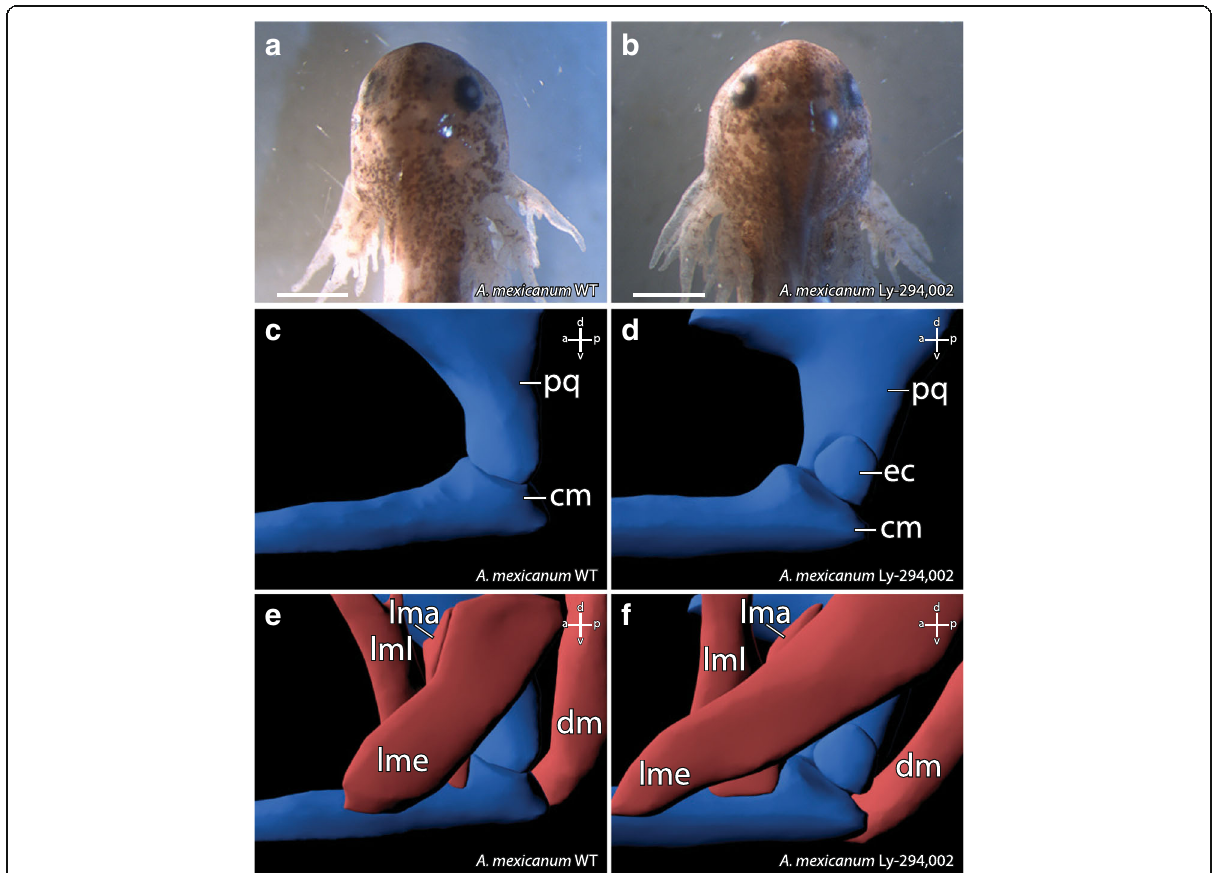
Fig. 7 Effect of Ly-294,002 treatment on the external and internal morphology of A. mexicanum . Dorsal view of a control and b Ly-294,002 treated specimens reveals no differences in external morphology. Lateral view of 3D-reconstructions based on confocal laser scanning microscopy of c control and d Ly-294,002 treated specimen shows the development of an ectopic cartilage lateral to the jaw articulation in treated specimens. The musculature of e control and f treated specimens are similar and no changes in origination or insertion of muscles can be observed after bapx1 upregulation. cm, Meckel ’ s cartilage; dm, M. depressor mandibulae; ec, ectopic cartilage; lma, M. levator mandibulae